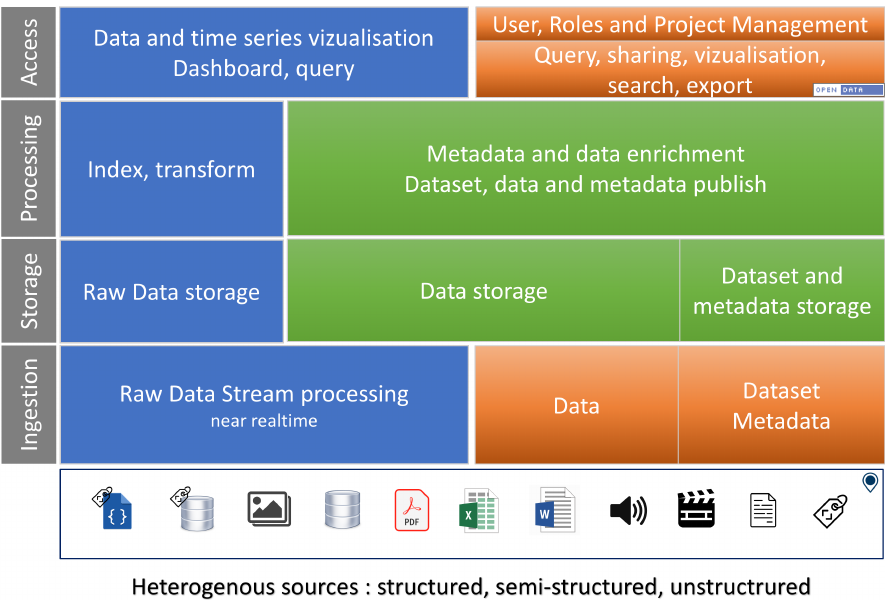
Figure 3. Global functionalities of CEBA (in blue IoT features, in orange web features and in green common